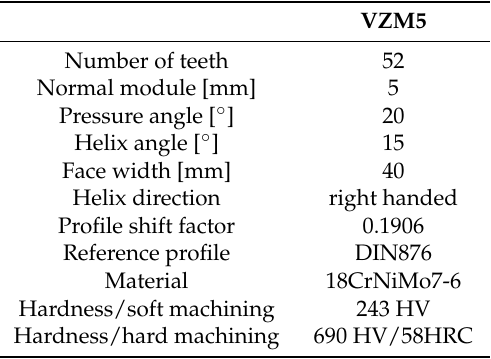
Table 1. Gear data of the module five test gear.